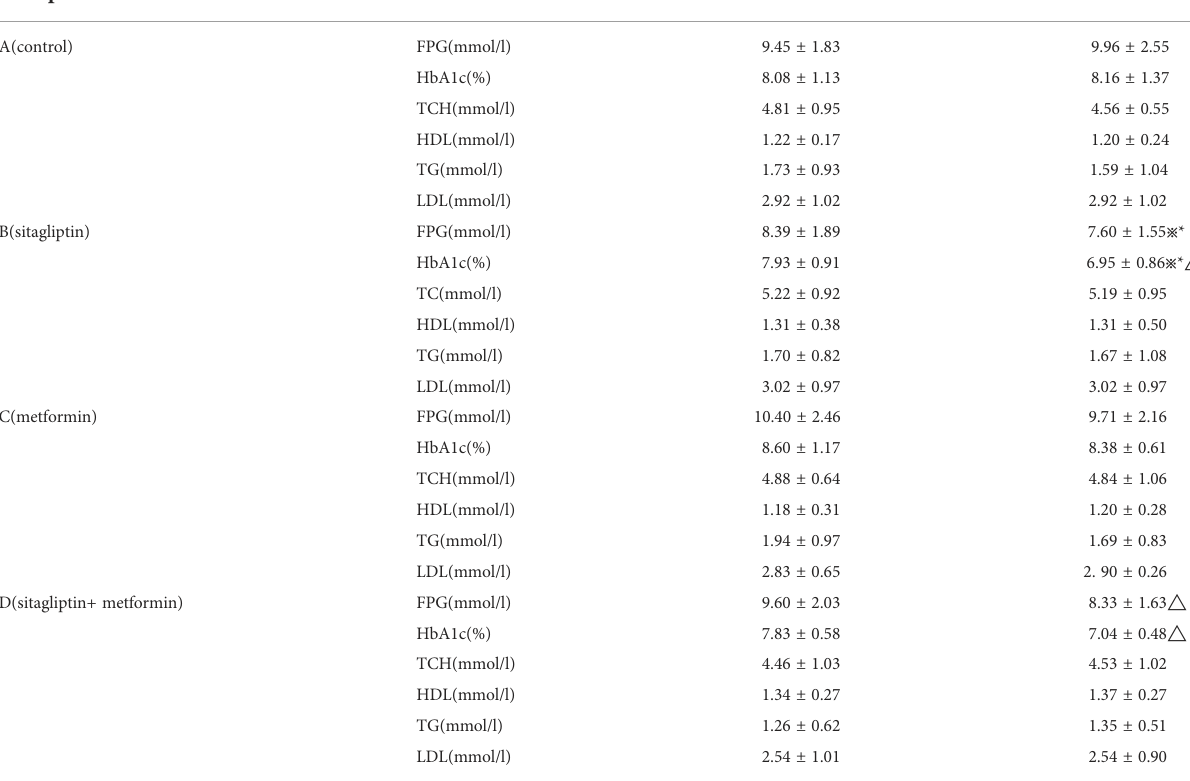
TABLE 3 Comparison of the glucose-lipid data between groups. Group At